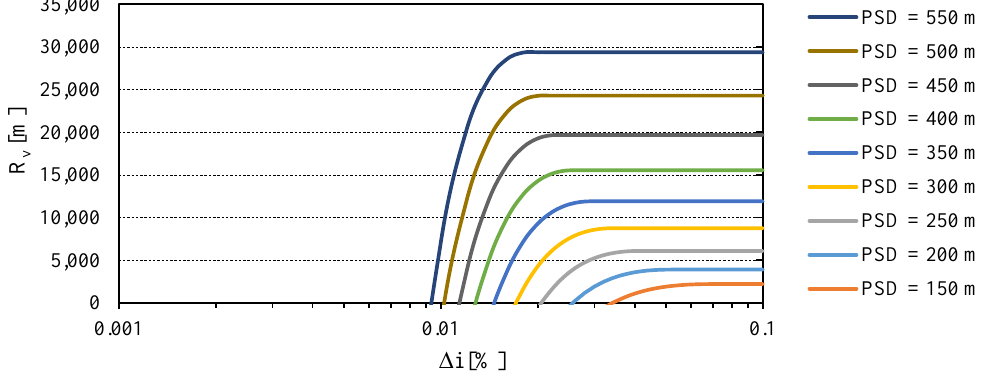
Figure 6. R v values (h 1 = 1.10 m and h 2(15) = 1.39 m).